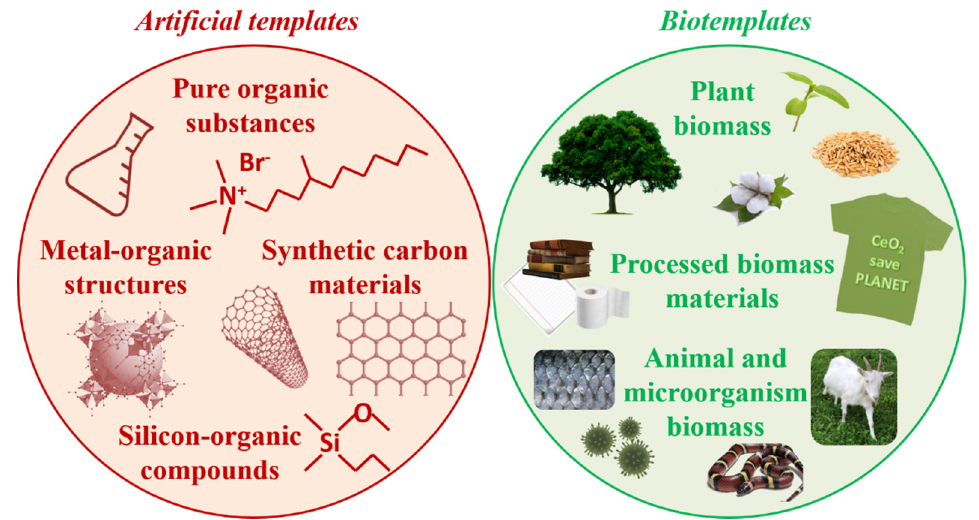
Figure 1. Schematic representation of the most common groups of artificial and biological materials used as templates for synthesis of ceria-based catalysts.